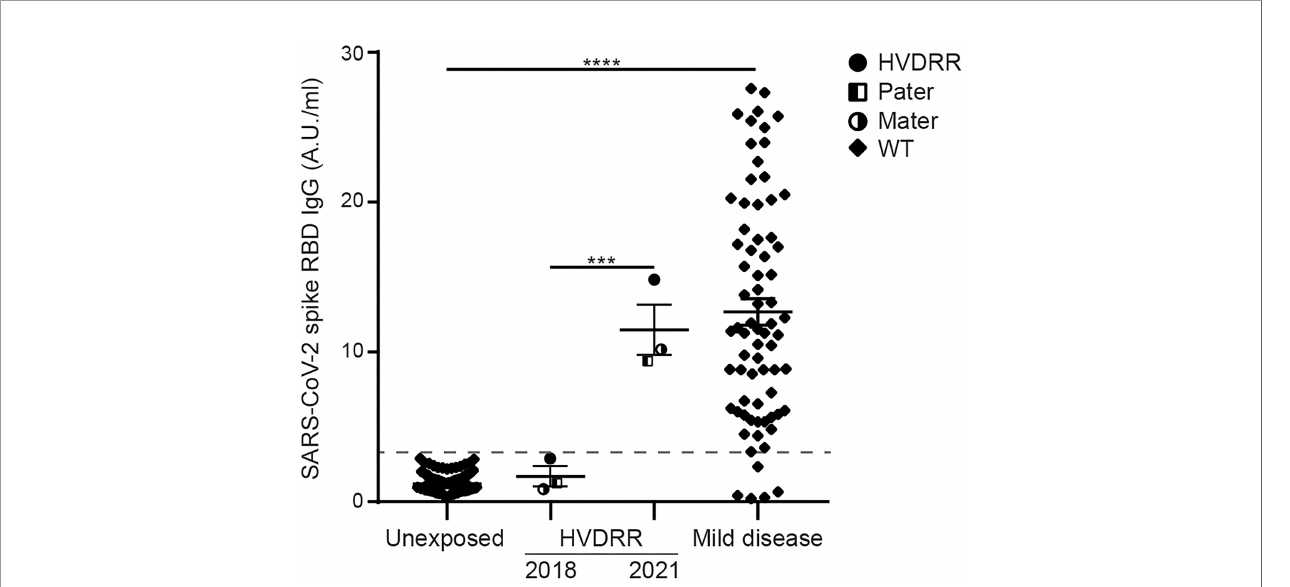
FIGURE 3 | Normal SARS-CoV-2 RBD-speci fi c IgG antibody titers in the plasma of the HVDRR patient and her parents. SARS-CoV-2 RBD-speci fi c IgG antibody titers in the plasma from unexposed subjects (n = 200), subjects with a mild course of COVID-19 (n = 72) and from the HVDRR patient and her parent from 2018 and 21 days after COVID-19 in 2021. The dashed line represents the cut-off for the ELISA (10). Antibody titers are shown for each individual and as mean ± SEM; ***p < 0.005, ****p < 0.001. HVDRR patient ( fi lled circles), pater (half- fi lled squares) and mater (half- fi lled